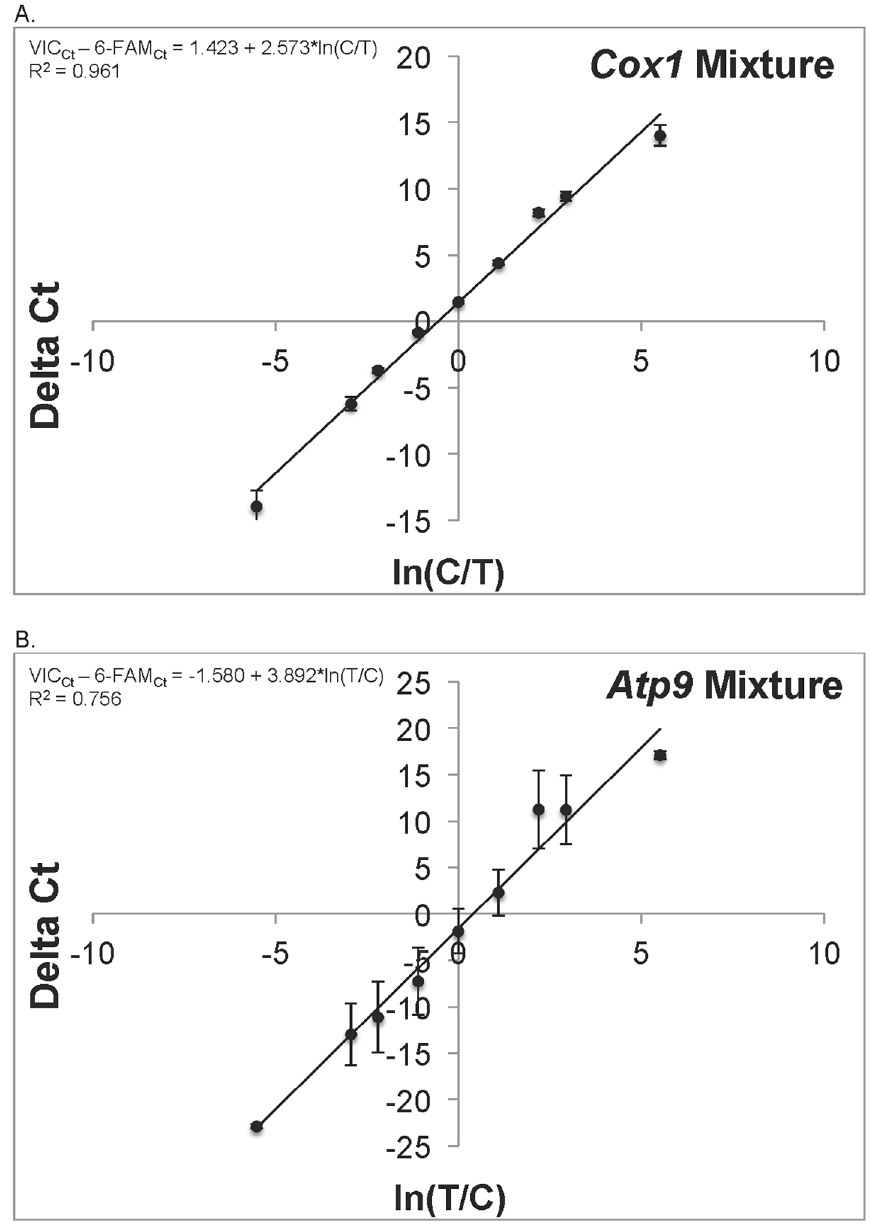
Fig 1. QPCR Mixture Experiments. A) The mean difference in probe-specific Ct values as a function of known relative concentrations of Cox1 haplotypes. B) The mean difference in probe-specific Ct values as a function of known relative concentrations of Atp9 haplotypes. Standard error bars for Ct value differences are also presented, based on six replicates for each relative concentration, along with the line derived from linear regression of mean difference in Ct values on log known relative concentration. Linear regression equations derived from these results are shown on the figure and are used to estimate relative copy number from observed Ct values for each probe pair in field-sampled